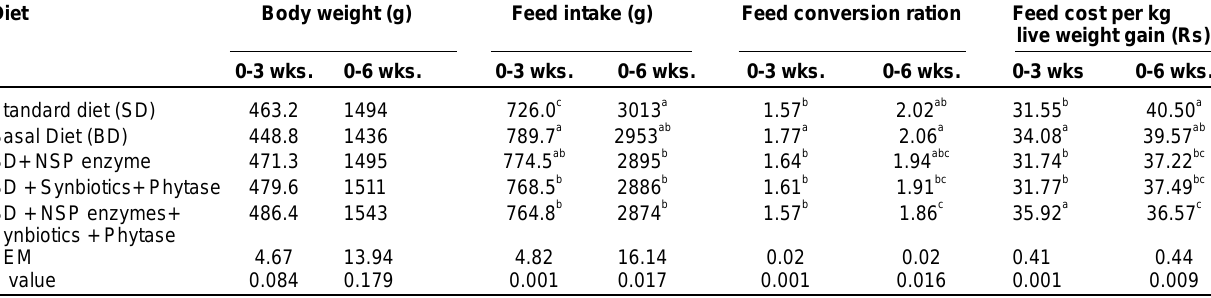
DM: Dry matter, OM: Organic matter, CP: Crude protein, EE: Ether extract, CF: Crude fiber, NFE: Nitrogen free extract, GE: Gross energy, TP: Total phosphorus. Each value is average of duplicate Table-5. Effect of feeding low calorie diet supplemented with NSP enzymes, synbiotics and phytase on performance and cost economics of broiler chicken Diet